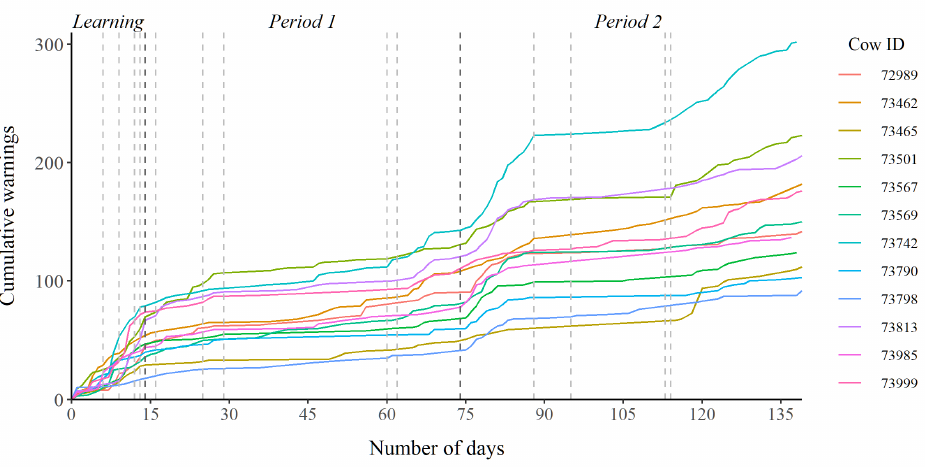
Figure 4. Cumulative number of warnings received by each cow during the three periods. The vertical lines in the plot mark any significant change in the virtual enclosure, where the darker lines indicate the division of the three